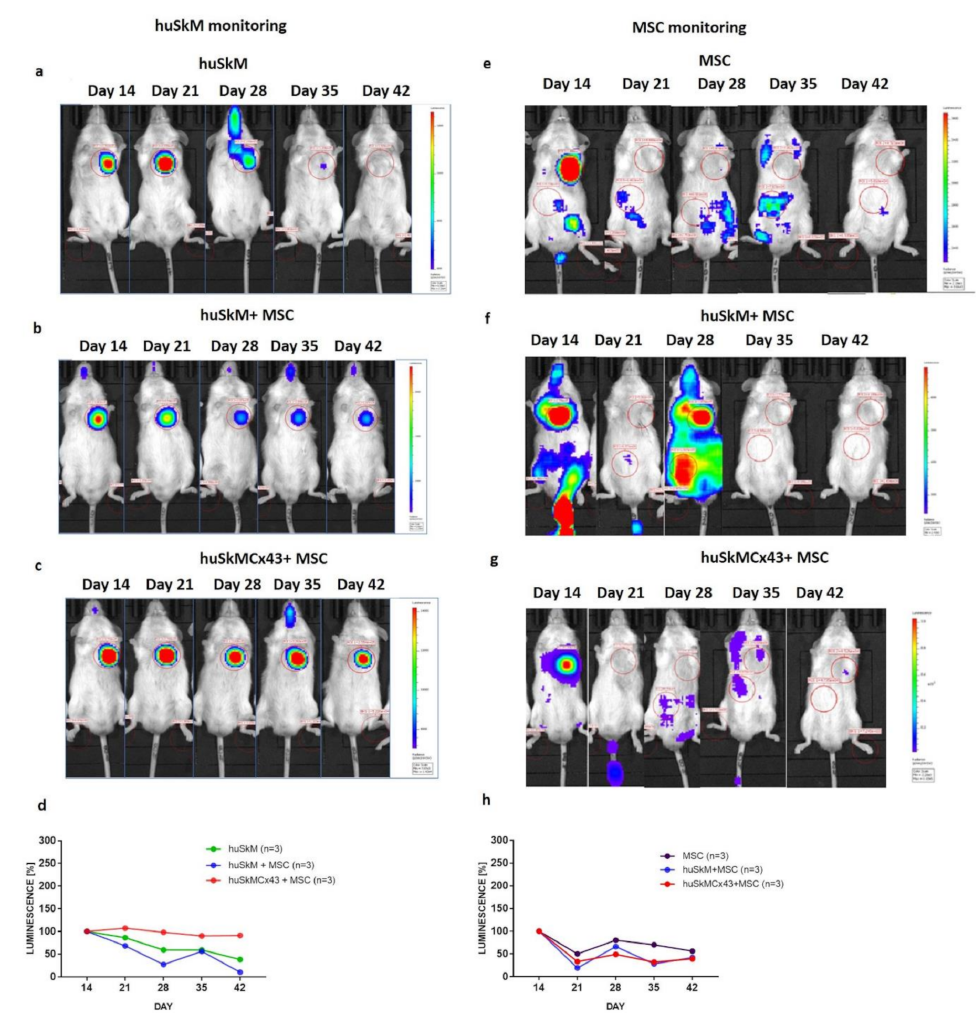
Figure 6. In vivo long-term monitoring of intramyocardially transplanted cells in a healthy mouse model (heart) determined by bioluminescence imaging. Images were taken on days 14, 21, 28, 35 and 42 after their delivery to the normal physiological heart. Each image is displayed on a rainbow scale in units of photon radiance (s –1 cm –2 sr –1 ) and overlaid onto a greyscale reference image of the corresponding mouse. Representative images of firefly luciferase luminescence intensity of huSkM transduced with MSCV-fluc-GFP reporter vector in ( a ). huSkM, ( b ). huSkM + MSC and ( c ). huSkMCx43 + MSC. ( d ). The percentage (%) of firefly luciferase luminescence signal intensity in huSkM transduced with MSCV-fluc-GFP reporter vector on days 14, 21, 28, 35 and 42 after the intervention (healthy heart) plotted for huSkM ( n = 3), huSkM + MSC ( n = 3), and huSkMCx43+MSC ( n = 3) (one-way Anova test followed by Tukey’s multiple comparison test). Representative images of nanoluciferase luminescence intensity in MSCs transduced with EF-1-mkate-nanoluc reporter vector in ( e ). MSC, ( f ). huSkM + MSC and ( g ). huSkMCx43 + MSC. ( h ) The percentage (%) of nanoluciferase signal intensity in MSC EF1-mkate-nanoluc reporter vector on days 14, 21, 28, 35 and 42 after the intervention (healthy heart) plotted for MSC, huSkM + MSC, and huSkMCx43 + MSC (one-way Anova test followed by Tukey’s multiple comparison